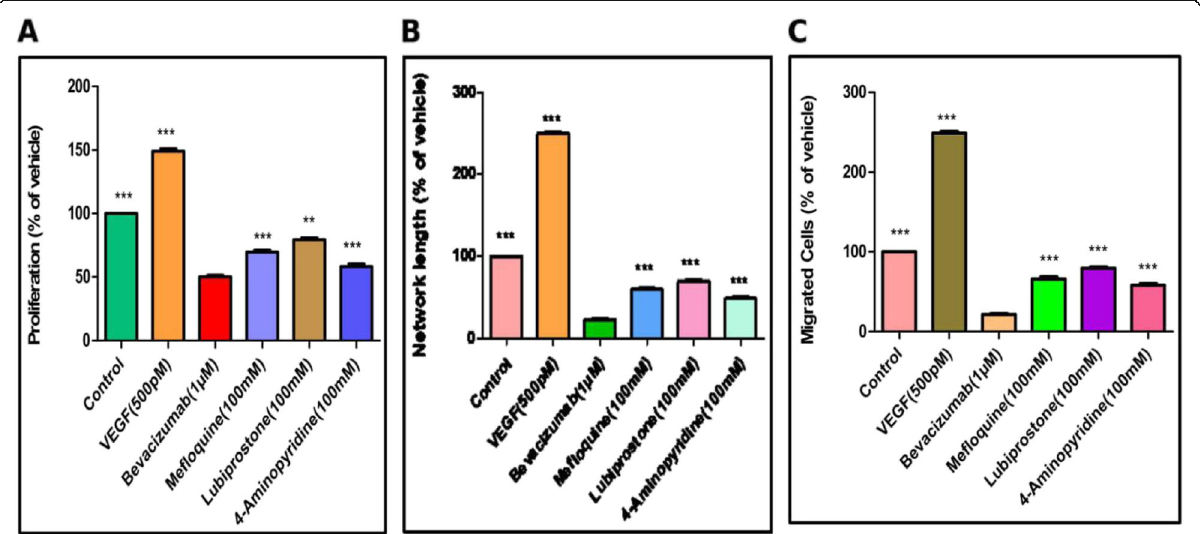
Fig. 4 Graphs showing the effect of ion channel modulators on a proliferation assay, b Matrigel cord-like morphogenesis assay, and c transwell migration assay. Results were presented as mean ± SEM. The differences between the groups were compared by one-way ANOVA followed by post hoc Dunnett ’ s test. In all the groups, n = 6. *** p < 0.001, ** p < 0.01, * p < 0.05 vs control, ns